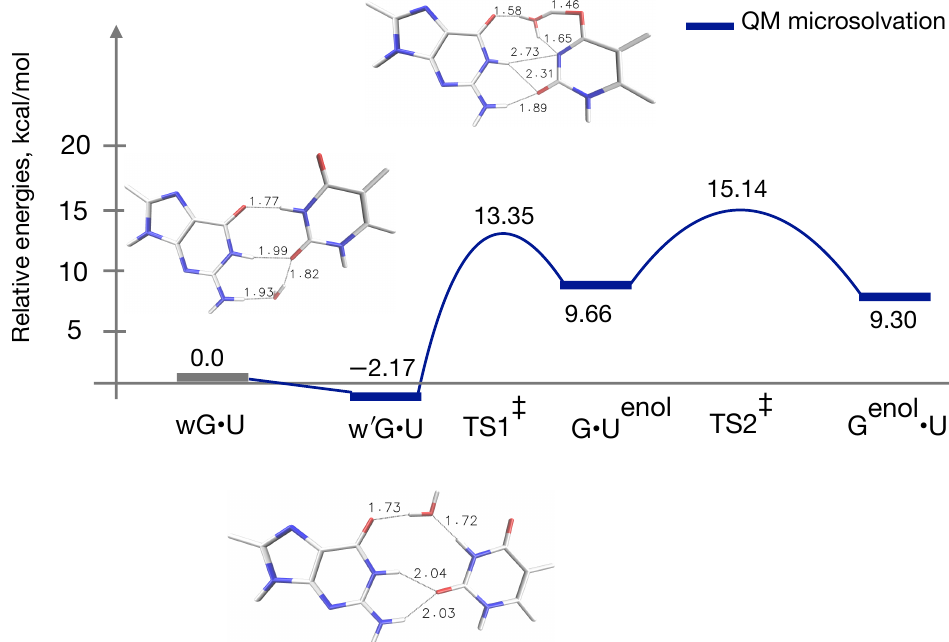
Figure 5. Reaction energy profile, and geometries of two types of wobble structures (wG • U and w ' G • U) and one transition state TS1 ‡ along the wG • U to WC-like tautomerization pathway obtained using QM calculations with microsolvation, see Figure 3 for the remaining three structures G • U enol , TS2 ‡ , and G enol • U , which are identical to those obtained from QM gas phase calculations. Here, one water molecule is present in addition to the G • U base pair. Relative energies (kcal/mol) are calculated with respect to the wG • U base